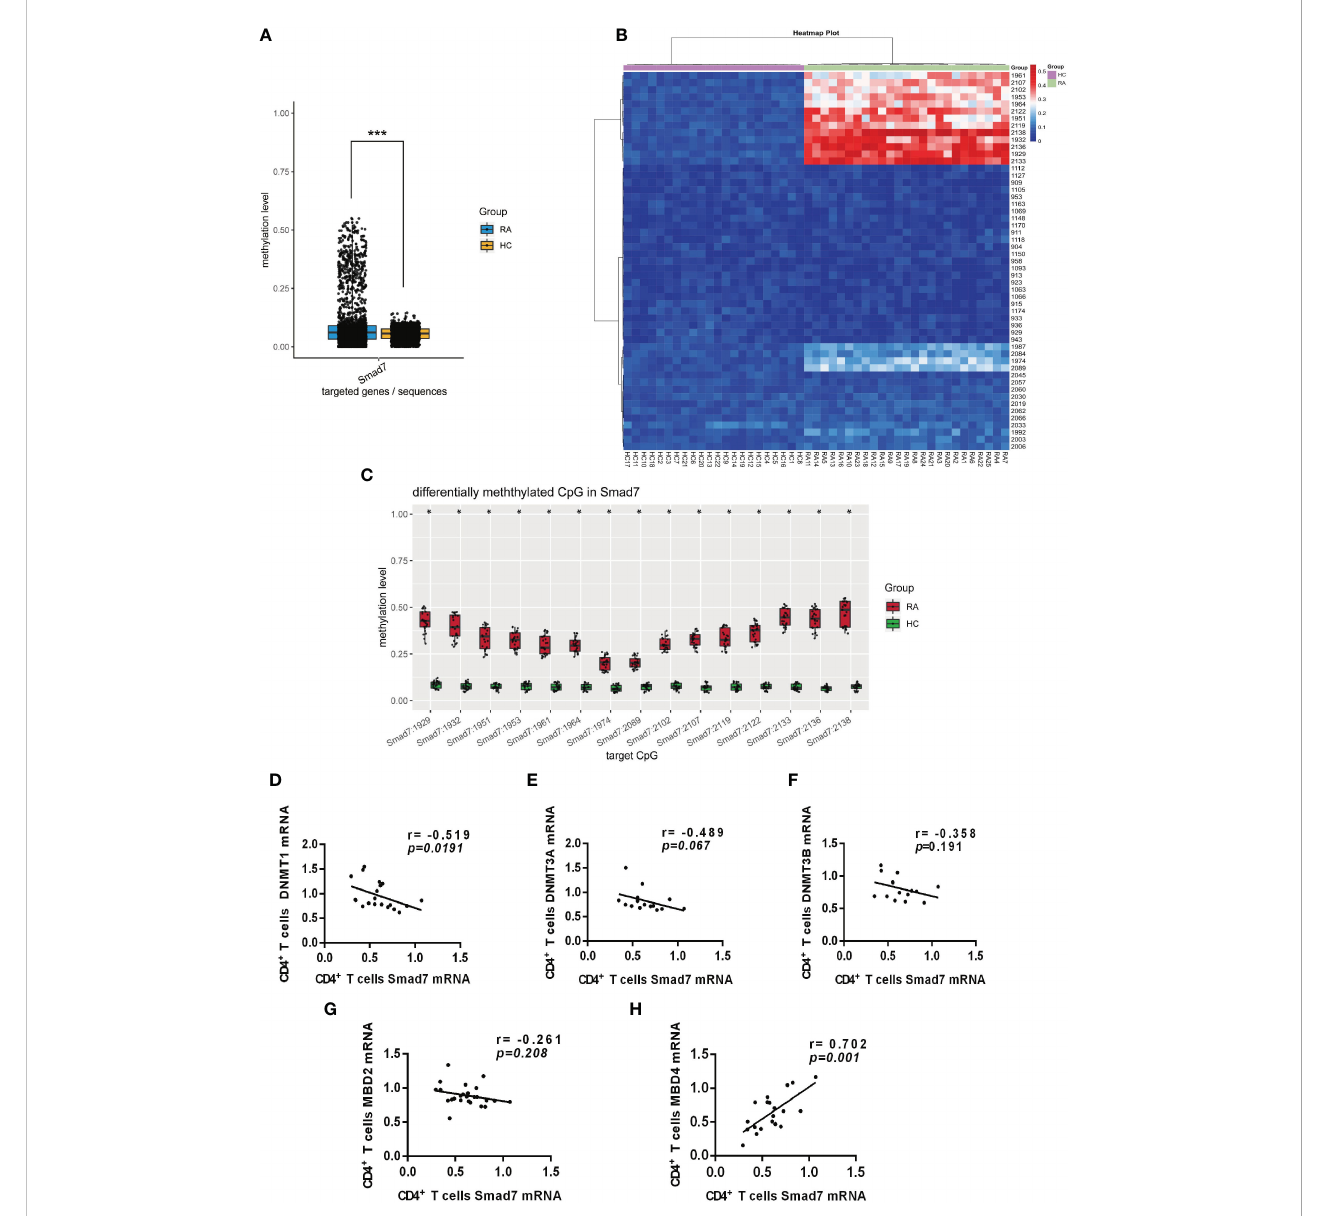
FIGURE 6 Smad7 promoter methylation of the peripheral CD4 + T cells from RA and health controls. (A) The mean methylation at the Smad7 promoter (-1000 to +2000bp) in CD4 + T cells from RA (n=25) and health controls (n=22) groups ( P= 7.1411e-05). (B) Heatmap shows that hypermethylation at the CG pairs (For the convenience of expression and counting, when we draw the heatmap, we count the positions according to the direction of the positive strand of the genome. That is, the position 1k downstream of the transcription start position of the gene is recorded as 1, and the position 2k upstream of the transcription start position is recorded as 3000, and counted according to this rule and marked in the picture. +927 (1929), +930 (1932), +949 (1951), +951 (1953), +959 (1961), +962 (1964), +972 (1974), +1087 (2089), +1100 (2102), +1105 (2107), +1117 (2119), +1120 (2122), +1131 (2133), +1134 (2136), +1136 (2138)) in the RA patients compared to health controls. (C) The average methylation status of the 15 CG pairs (positions: +927 (1929), +930 (1932), +949 (1951), +951 (1953), +959 (1961), +962 (1964), +972 (1974), +1087 (2089), +1100 (2102), +1105 (2107), +1117 (2119), +1120 (2122), +1131 (2133), +1134 (2136), +1136 (2138)) is signi fi cantly increased in CD4 + T cells from RA patients compared to the health individuals. (D – F) Correlation of Smad7 mRNA with DNMT1, DNMT3A, or DNMT3B mRNA in CD4 + T cells in RA patients. (G, H) Correlation of Smad7 mRNA with MBD2 or MBD4 mRNA in CD4 + T cells from RA patients. Each dot represents one individual. * P < 0.05, *** P < 0.05.